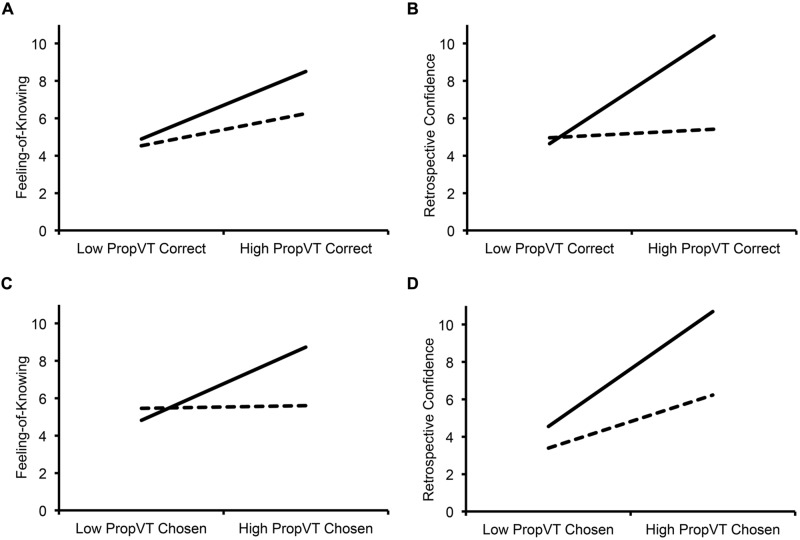
The estimated relationship between proportion of viewing to the correct/chosen face and metamemory judgments. Correct responses are shown in solid lines and incorrect responses in dashed lines. A higher proportion of viewing directed to the correct face was associated with higher FOK judgments for correct and incorrect recognition (A), but was associated with higher RCJs for correct recognition only (B). In contrast, a higher proportion of viewing directed to the chosen face was associated with higher FOK judgments for correct recognition only (C), but was associated with higher RCJs for correct and incorrect recognition (D). PropVT Correct = Proportion of Viewing Time directed to the Correct Face; PropVT Chosen = Proportion of Viewing Time directed to the Chosen Face.